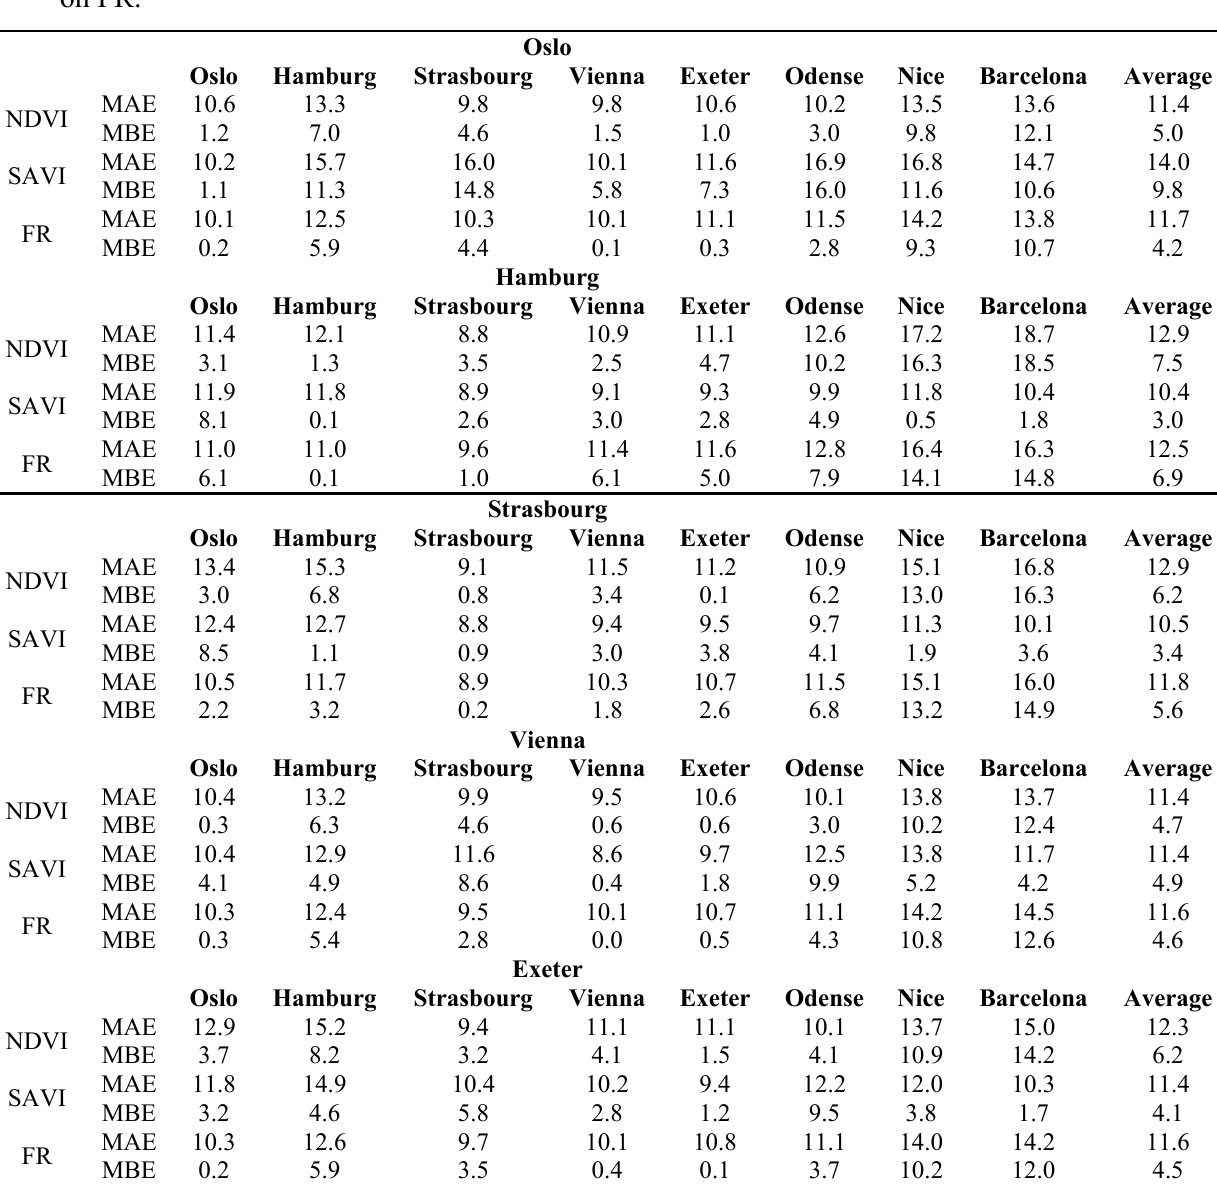
Table A1. MAE’s and absolute MBE’s for all possible combinations of methods and urban areas using the second order polynomial regression models. Table titles = the city where the models were developed. NDVI = NDVI models, SAVI = SAVI models, FR = models based on